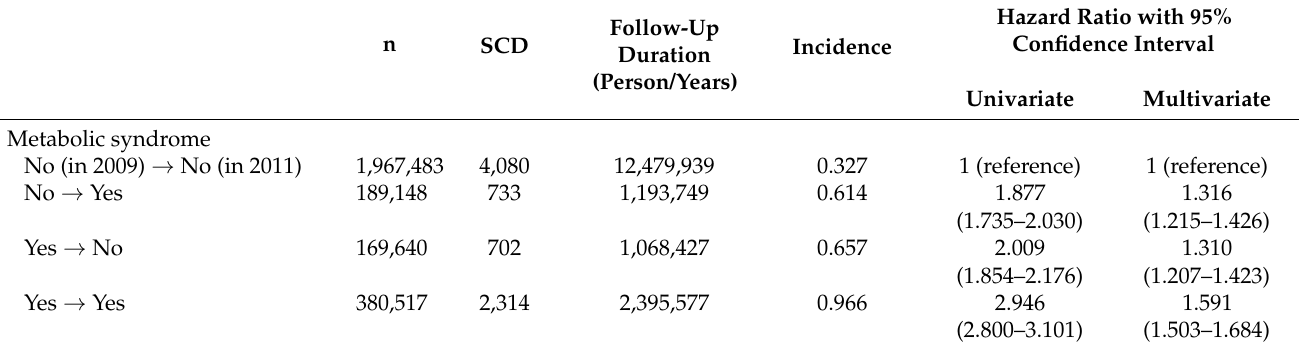
Table 5. Impact of changes in metabolic syndrome status on SCD development.